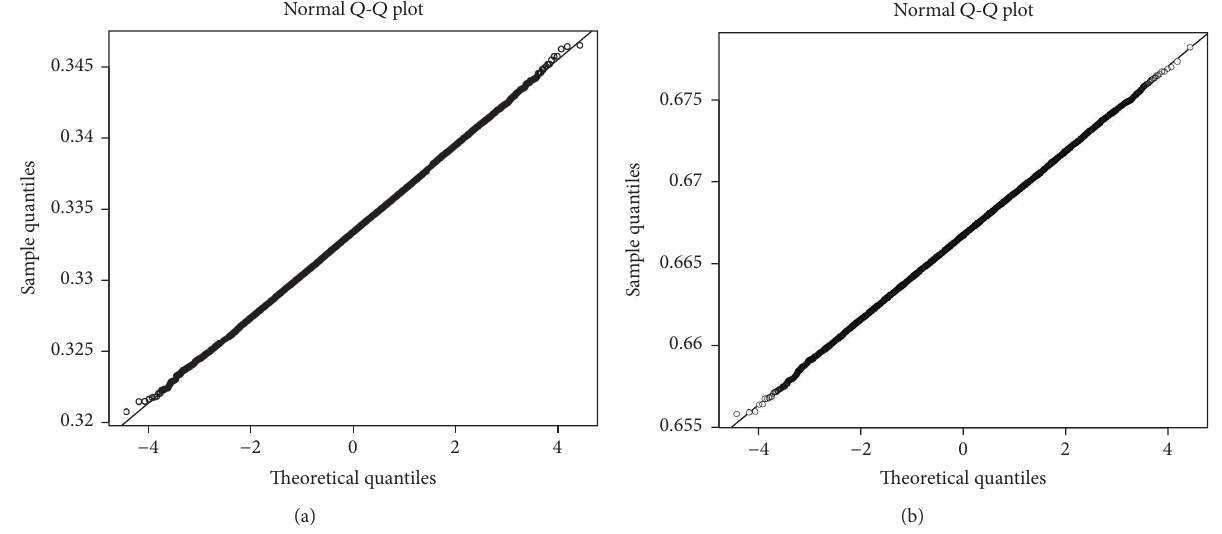
Figure 3: (a) for 𝛽 1 and (b) for 𝛽 2 : the Q-Q plot of the 1000 estimators of every